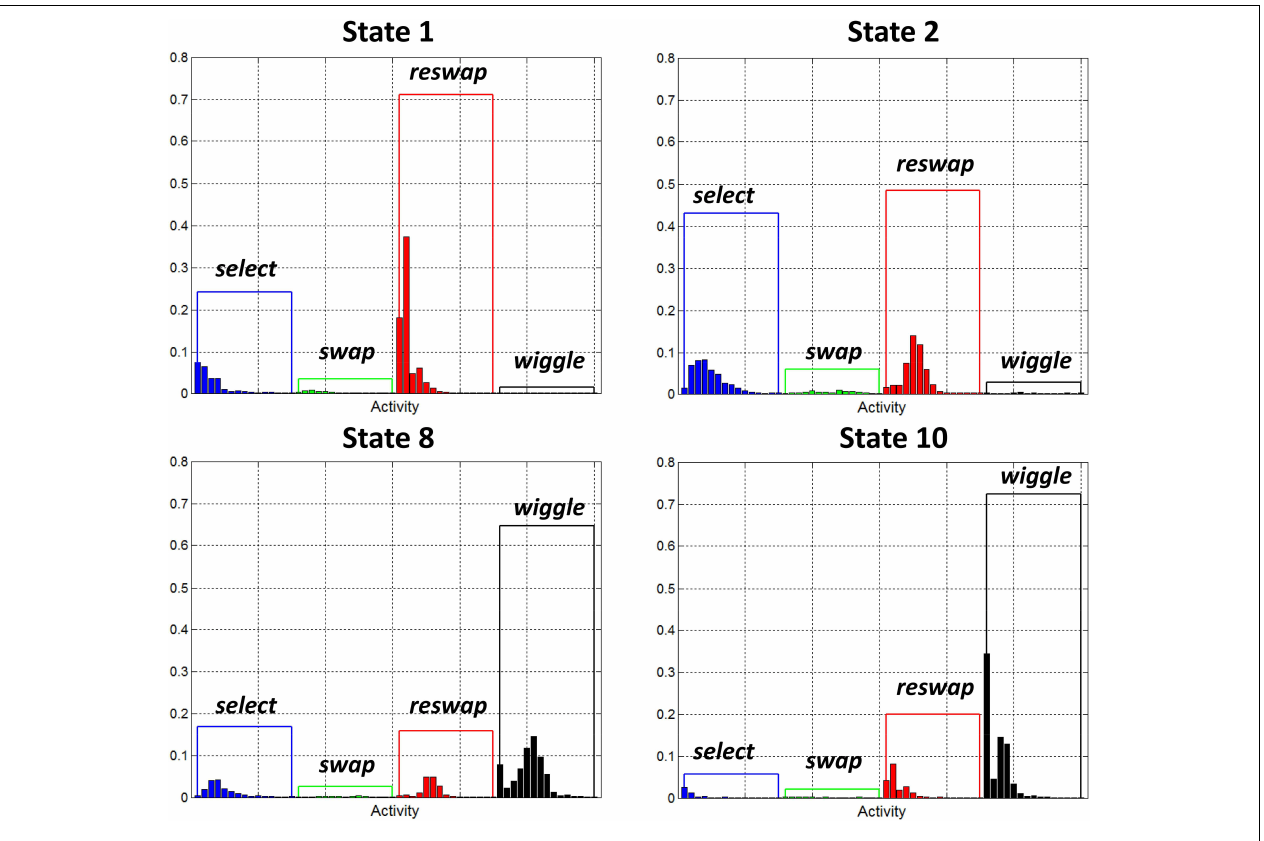
FIGURE 6 | Observation probability distributions for states 1, 2, 8, and 10. Each of these states has been identified as a “random search” state. They represent the behavior of participants who haven’t yet discovered how to score points in the game, as